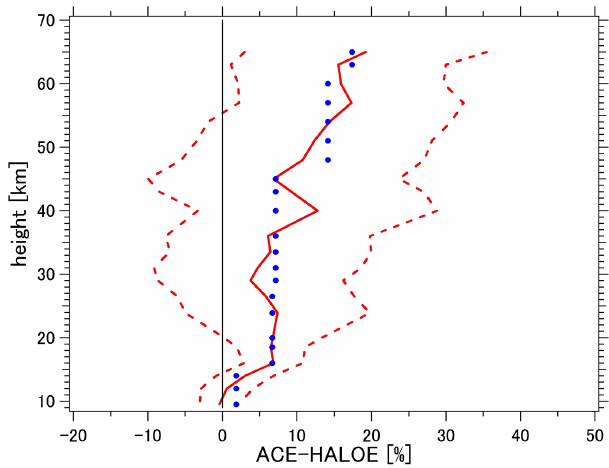
Figure 2. Average (solid red line) CH 4 concentration difference ± 1SD (dashed red lines) between ACE-FTS and HALOE data. At latitudes without ACE-FTS profile data, the values shown by the blue dots at the respective altitudes were used instead of ACE-FTS CH 4 data for estimating stratospheric and mesospheric profiles. See text for more